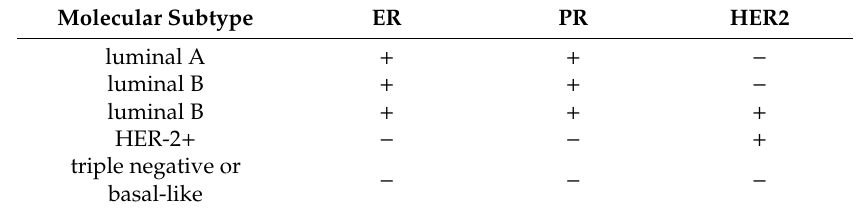
Table 1. Relationship between the molecular breast cancer (BC) subtypes and immunohistochemical markers (ICMs)